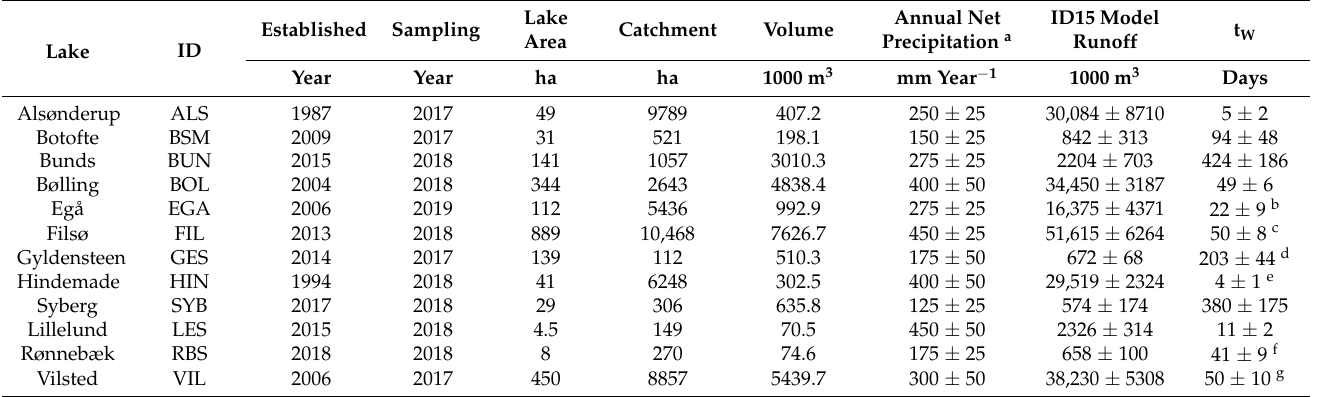
Table 1. Year of establishment, year of sampling, the lake area, lake volume, catchment area, and annual hydrological residence time modeled from the DNC model of the 12 selected new